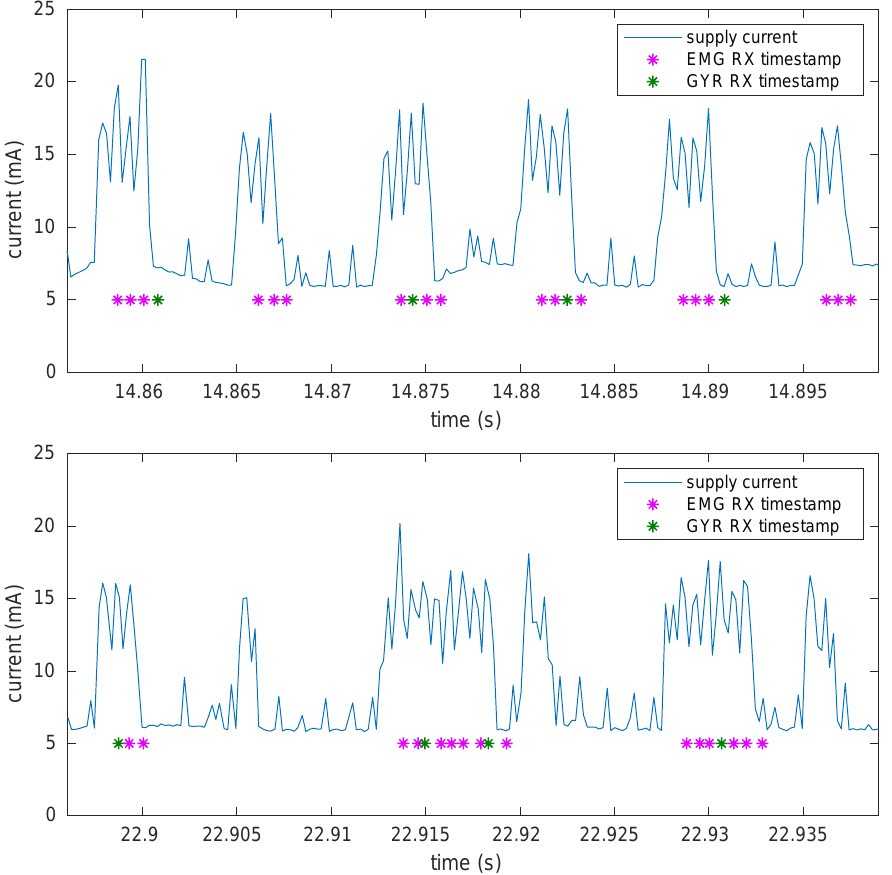
Figure 5. Total supply current to the sensor node and packet reception timestamps. Spikes around 15mA correspond to the activation of the radio transmitter, while the lower spikes (around 8mA) to CPU activity (mostly sensor data readout). The baseline is higher than normal because the measurement was performed with a debug probe attached to better analyse timing and firmware behavior, but it does not otherwise affect the results. Stars (placed at an arbitrary height) denote the time at which a packet was received by the PC acting as central. The time scales of the current measurement instrument and of the PC with the bluetooth receiver had been synchronized by servoing both clocks to the same, local time server. A BLE 4.0 dongle was used for the measure, so the on-air bit-rate is